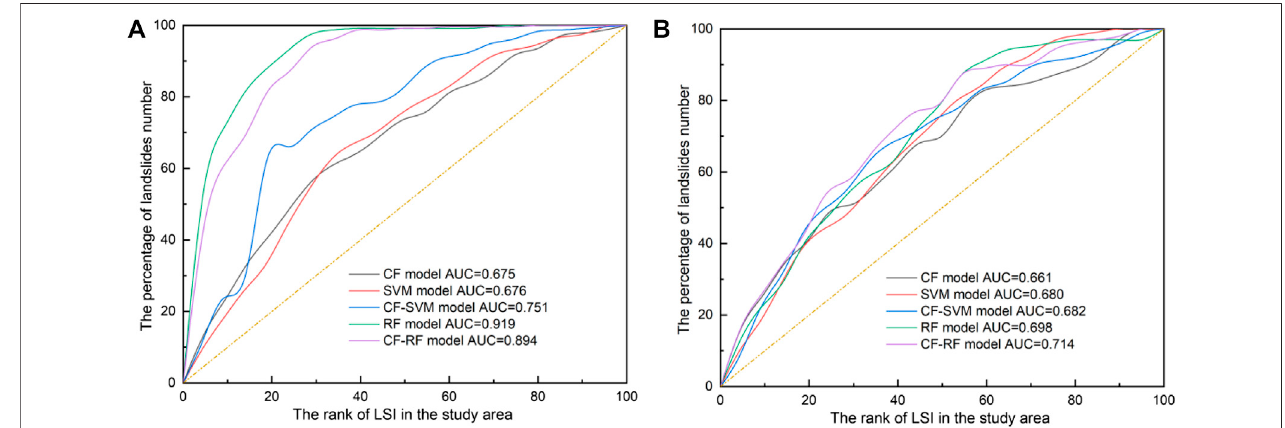
FIGURE 7 | Analysis of the ROC curves of the fi ve models: (A) success rate curves. (B) prediction rate curves.